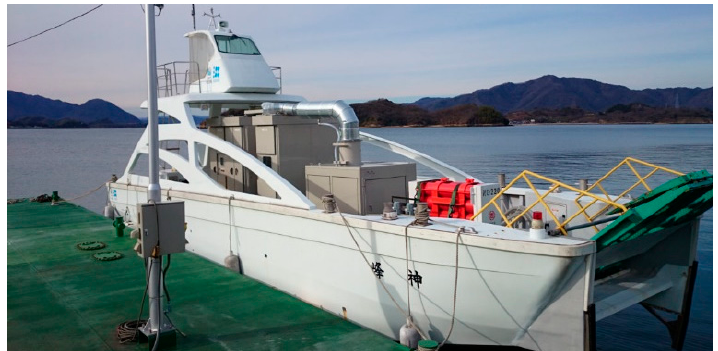
Figure 27. The ship “Shimpo” [130,131].